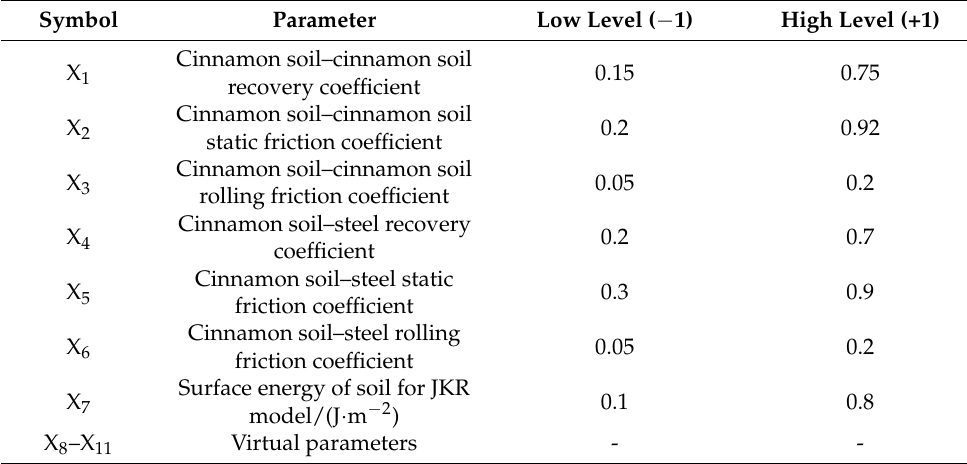
Table 2. Parameters of the Plackett – Burman test.